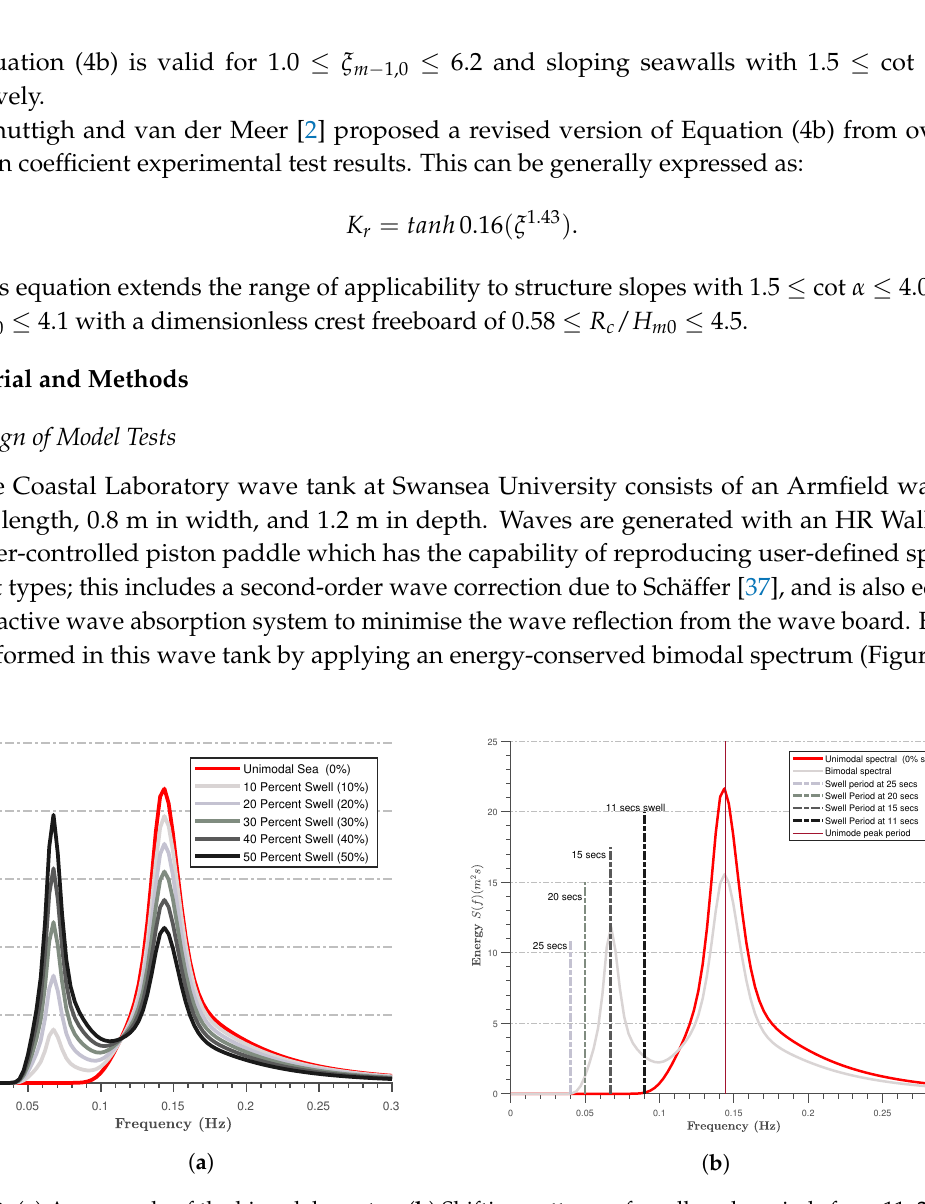
Figure 2. ( a ) An example of the bimodal spectra. ( b ) Shifting patterns of swell peak periods from 11–25 s